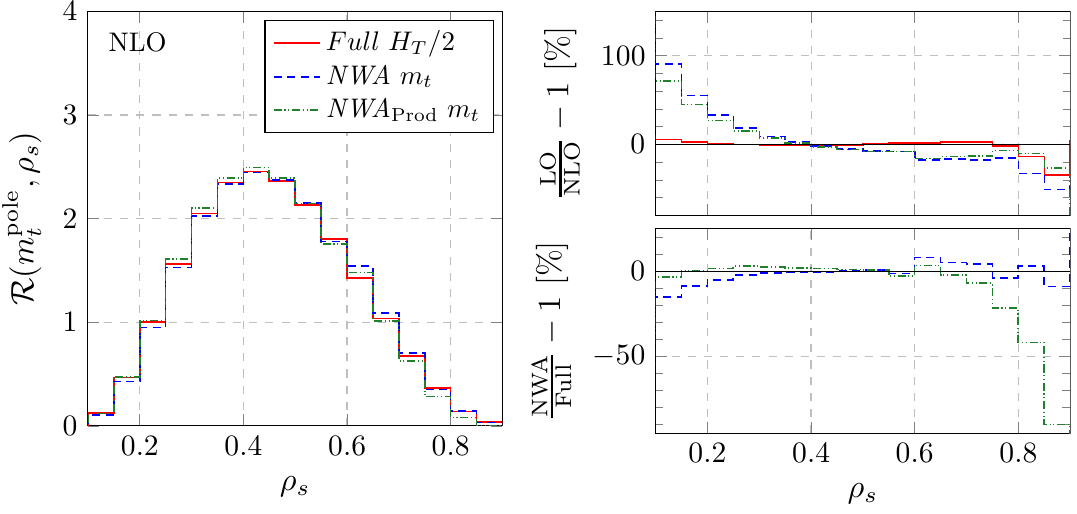
(cid:22) bj + X + (cid:23) Figure 3 . Normalised (cid:26) s di(cid:11)erential distribution at NLO QCD for the pp ! e e (cid:22) (cid:0) (cid:22) (cid:23) (cid:22) b production process at the LHC with p s = 13 TeV. Three di(cid:11)erent theoretical descriptions with m t = 173.2 GeV are shown. Also given are the relative size of NLO QCD corrections and the com- bined relative size of (cid:12)nite-top-width and (cid:12)nite-W-width e(cid:11)ects for the normalised (cid:26) s observable. Renormalisation and factorisation scales are set to the common value (cid:22) R = (cid:22) F = (cid:22) 0 where (cid:22) 0 = m t for both NWA cases and (cid:22) 0 = H T = 2 for the Full case. The CT14 PDF set is